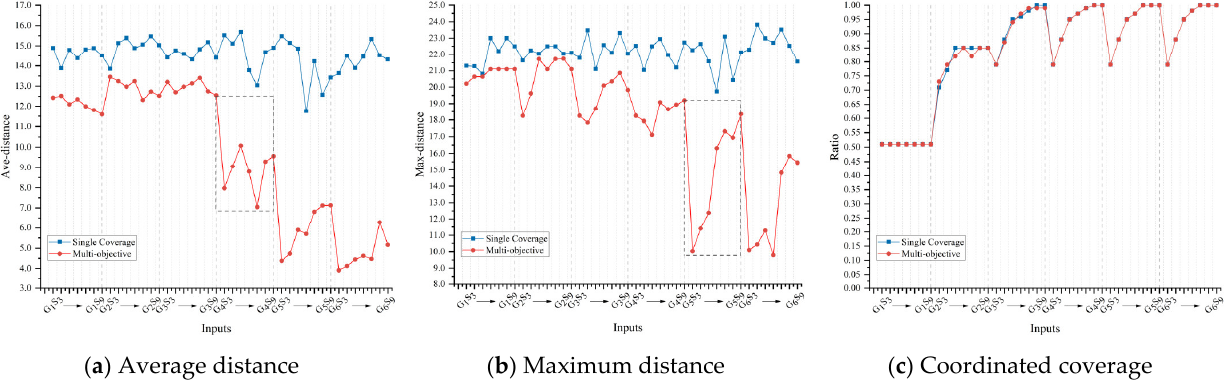
Figure 9. Location strategies between multi-objective and the single coverage.